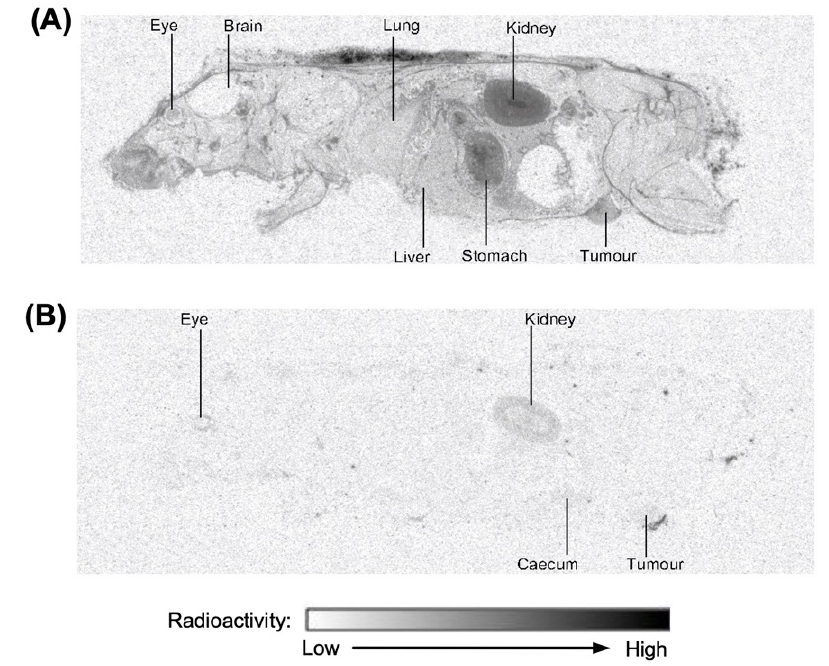
Figure 2. Representative images of distribution of radioactivity in perfused female BALB/c mice with 4T1 cell tumours 0.5 h ( A ) and 3 h ( B ) after intravenous administration of [ 3 H]-CEND-1 at a target dose of 5 mg/kg. Table 3. Distribution of radioactivity in tissues of perfused female BALB/c mice following a single